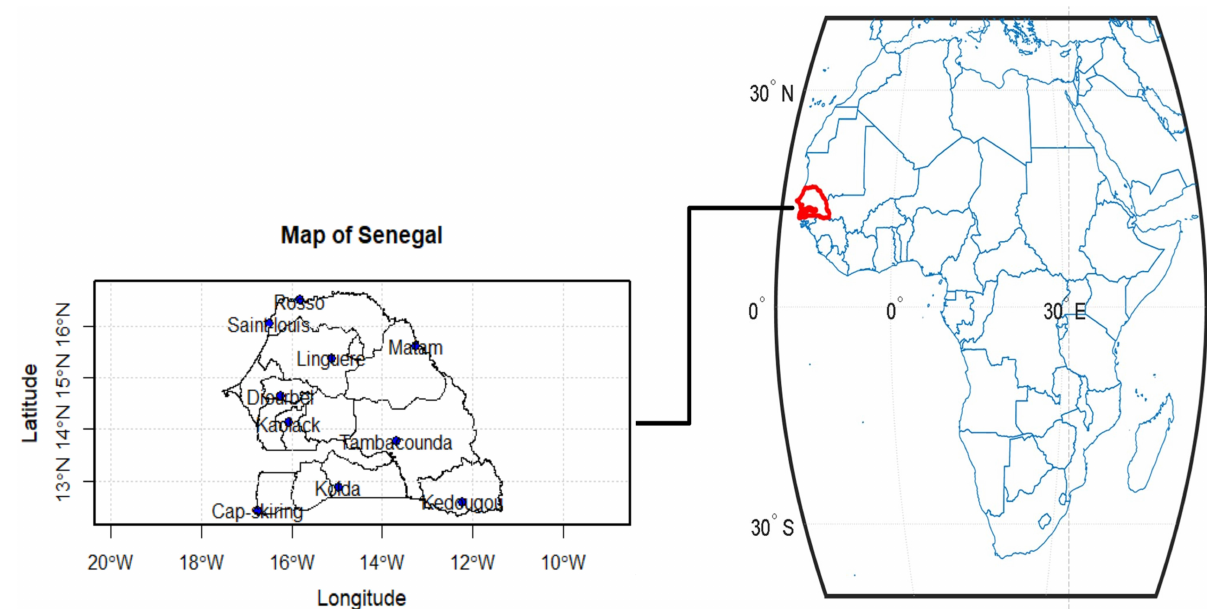
Figure 1. Map of Senegal with its ten data source locations (at left).